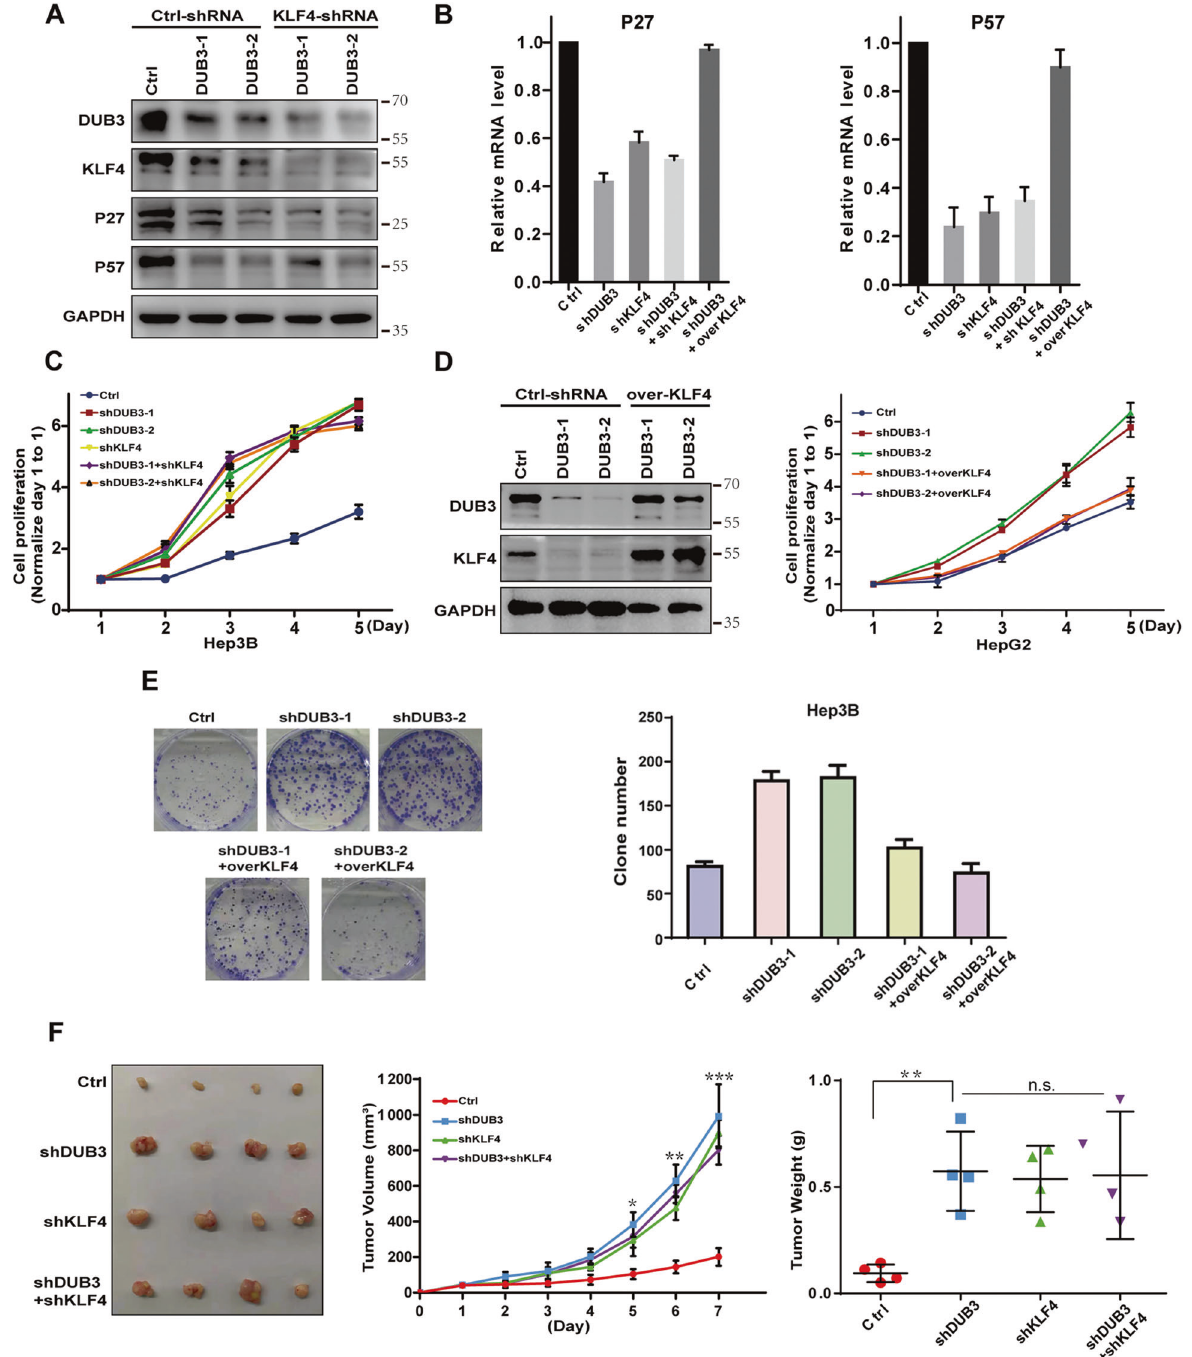
Fig. 4 Knockdown of DUB3 promoted HCC cell proliferation and tumor growth via suppressing KLF4 expression. A Hep3B cells stably expressing control or the indicated shRNAs were harvested and lysed. Western blotting was carried out to determine protein expression of DUB3, KLF4, P27, and P57. B Quantitative real-time PCR (qRT-qPCR) was performed to measure mRNA levels of P27 and P57 in Hep3B cells stably expressing the shRNAs or KLF4 as indicated. C Hep3B cells were transfected with shDUB3 and shKLF4 alone or in combination. CCK8 assay was performed to examine cell proliferation at 1, 2, 3, 4, and 5 days after transfection. D HepG2 cells stably expressing shDUB3 were transfected with control or vectors expressing KLF4. Western blot analysis was carried out to detect DUB3 and KLF4 expression (left panel). CCK8 assay was performed to examine cell proliferation at 1, 2, 3, 4, and 5 days after transfection (right panel). Data are expressed as the mean ± SEM. * P < 0.05, ** P < 0.01, *** P < 0.001, vs. Ctrl; n = 3. E Hep3B cells were transfected with shDUB3 alone or in combination with KLF4, colony formation assay was used for cell proliferation analysis. F Hep3B cells (2 × 10 6 ) cells transfected with shDUB3 and shKLF4 alone or in combination were implanted subcutaneously in BALB/c nude mice. The volumes of tumors were measured daily. Tumors were collected 4 weeks after inoculation. Tumor images are shown. Data are expressed as the mean ± standard deviation. * P < 0.05, ** P < 0.01, *** P < 0.001, vs. Ctrl; ns, non-signi fi cant; n = 4.